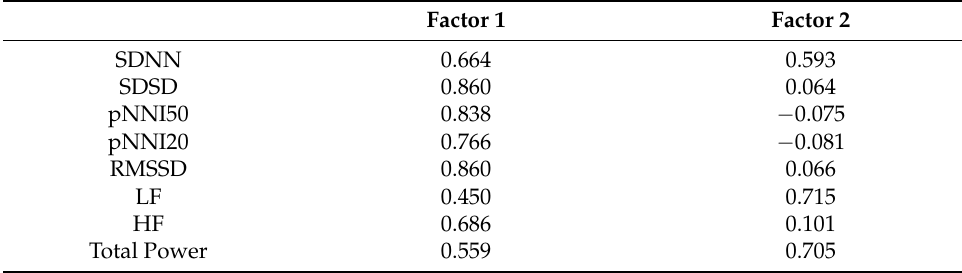
Table 6. The eigenvalues from factor